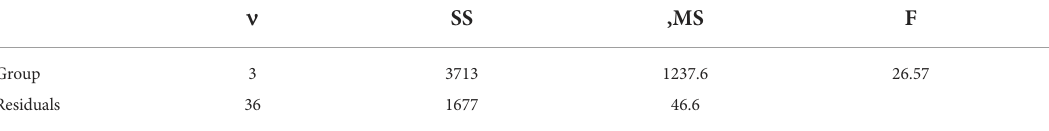
TABLE 13 Results of ANOVA of IL-23.